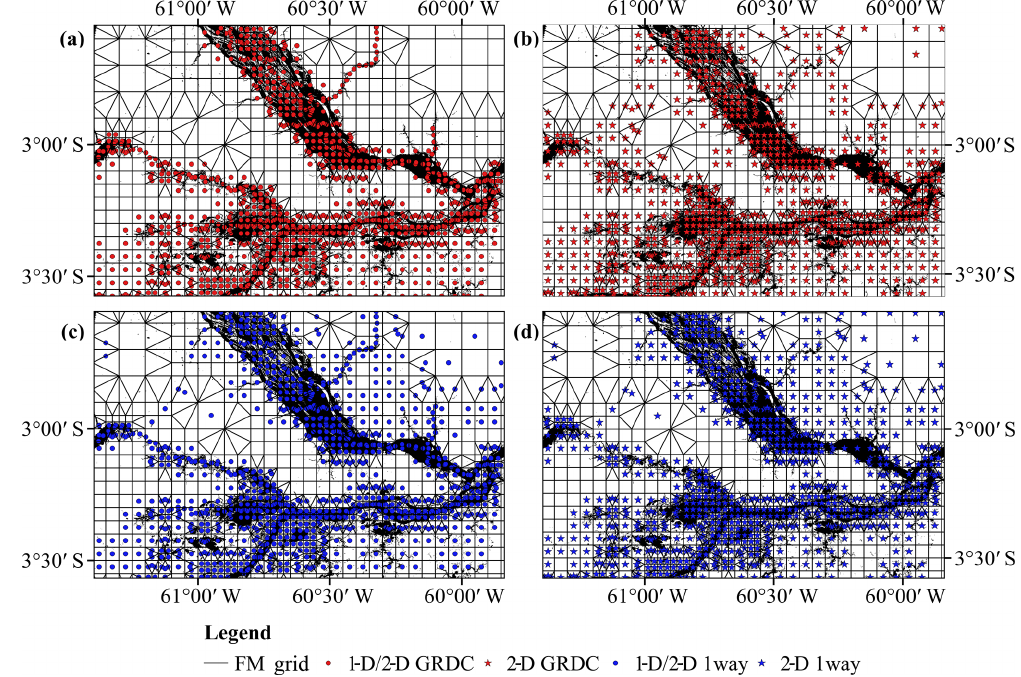
Figure 8. Plot of simulated inundation extent per model set-up compared to observed water body extent as observed by LandSat imagery on 1 July 1989; the validation is performed for (a) the 1-D/2-D GRDC run, (b) the 2-D GRDC run, (c) the 1-D/2-D one-way (1way) run, and (d) the 2-D one-way (1way)